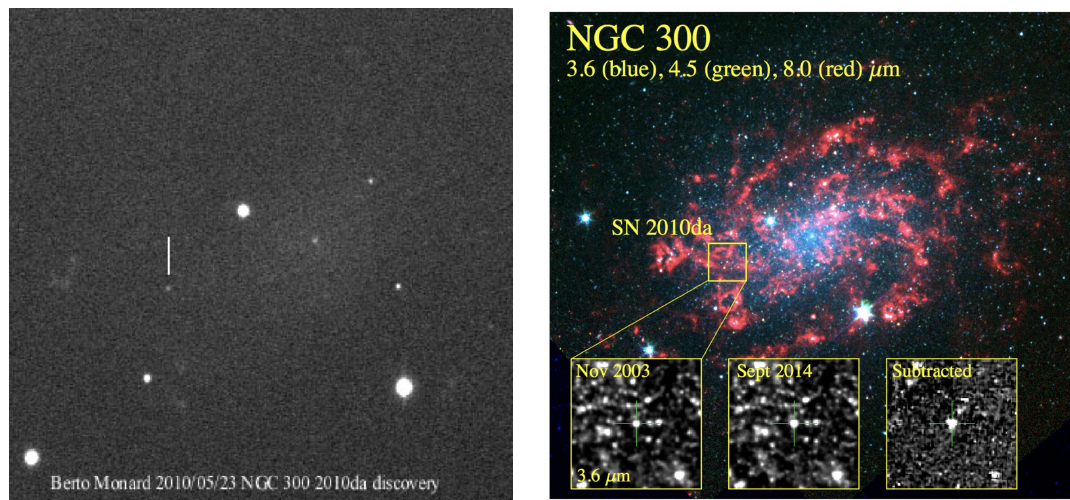
Figure 1. ( Left ): The initial discovery image [8] of SN 2010da by L.A.G. Monard [1]. ( Right ): An RGB-rendered IR composite image of NGC 300, with insets showing the 3.6 µ m image of the progenitor ( ∼ 6.5 years pre-outburst), ∼ 4.5 years post-outburst, and the difference subtracted image. Reproduced with permission from Lau et al. [9] (their Figure